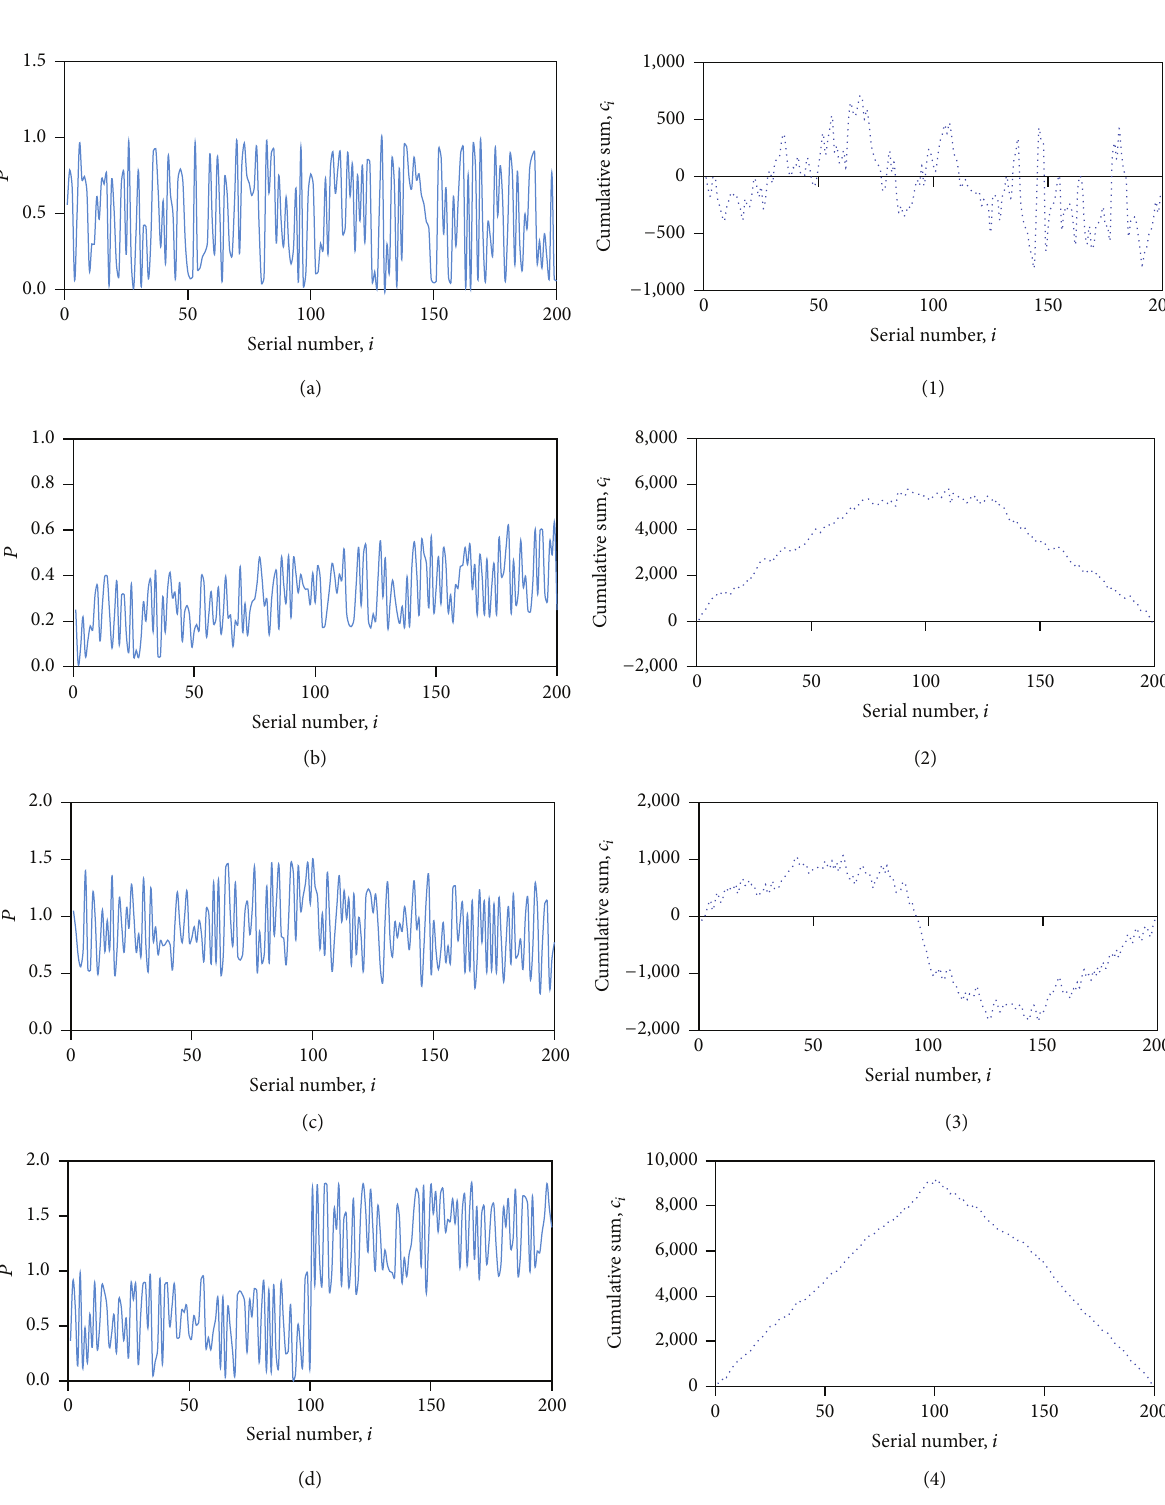
Figure 2: The plots for (a)–(d) synthetic series, 𝑃 of 𝑛 = 200 , and (1)–(4) the cumulative effects of the temporal variations for the corresponding